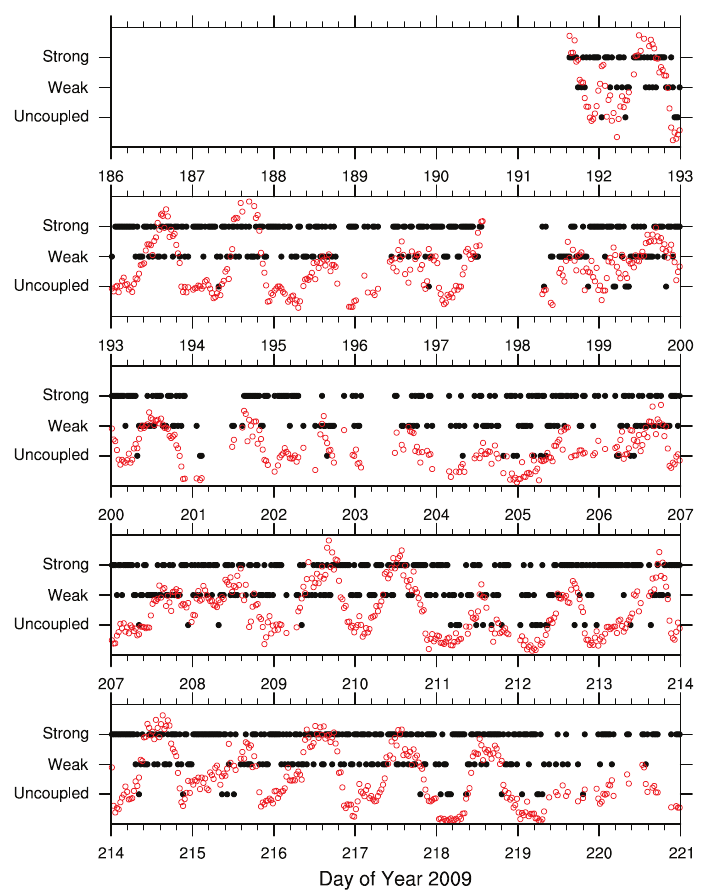
Figure 10. Time series of coupling over the duration of the campaign (black closed 847 Fig. 10. Time series of coupling over the duration of the campaign (black closed circles). Friction velocity (red open circles) is shown for reference. circles). Friction velocity (red open circles) is shown for reference. 848